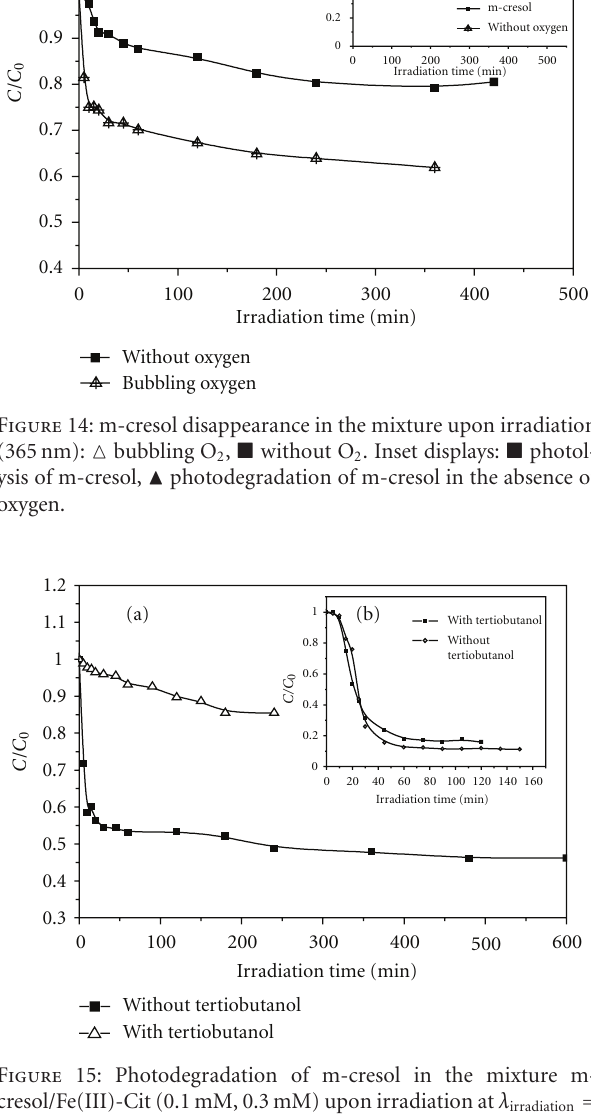
Figure 13: m-cresol disappearance in the mixture upon irradiation (365nm) at di ff erent m-cresol concentrations: (cid:5) [m-cresol] = 0.2 × mM, • [m-cresol] = 0.1mM, (cid:3) [m-cresol] = 0.8 × 10 − 1 mM.